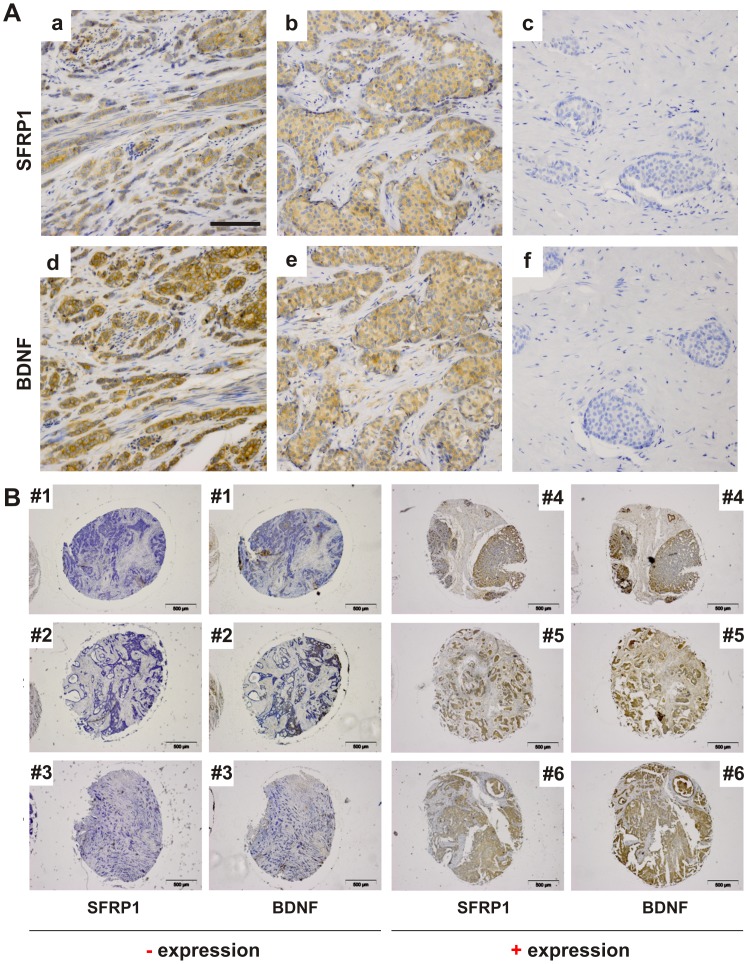
Analysis of SFRP1 and BDNF expression in human breast tissues.(A) Immunohistochemical staining of human breast tissues is shown exemplarily. SFRP1 and BDNF protein expression of tissue samples from the same patient (a and d, b and e) is shown. c and f: negative controls of SFRP1 and BDNF immunohistochemical staining, respectively. Scale bar: 100 µm. (B) In the left columns three tissues (patient #1 - #3) exhibit no or weak staining of SFRP1 and BDNF whereas the right columns represent three tissues (patient #4 - #6) that have a strong SFRP1 and BDNF protein expression. These images illustrate exemplarily the correlation of SFRP1 and BDNF protein expression in vivo. Scale bars: 100 µm.